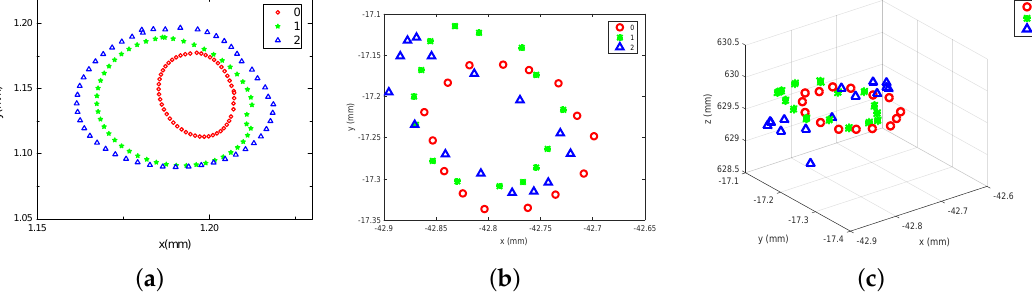
Figure 10. The trajectories of three methods with different additional weight at 2400 rpm rotating speed: ( a ) laser displacement method; ( b ) eddy current method; and ( c ) the proposed method. 0